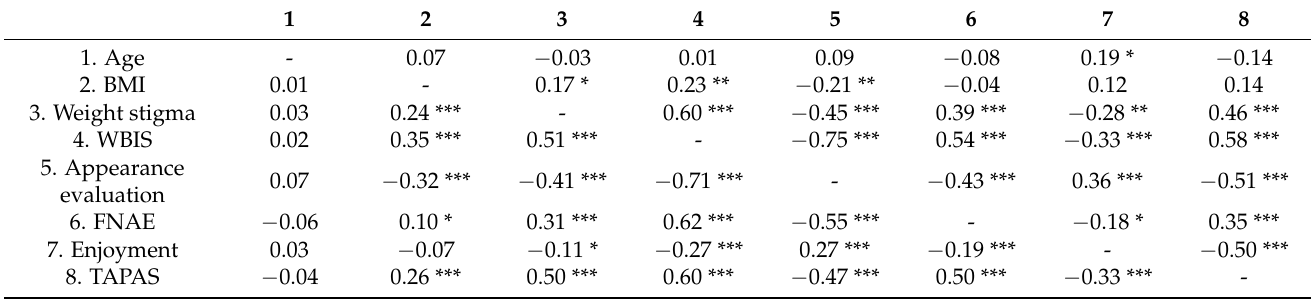
Table 2. Pearson’s product moment correlations between all variables. Correlations for men ( N = 151) are displayed above the diagonal, and women ( N = 427) are displayed below the